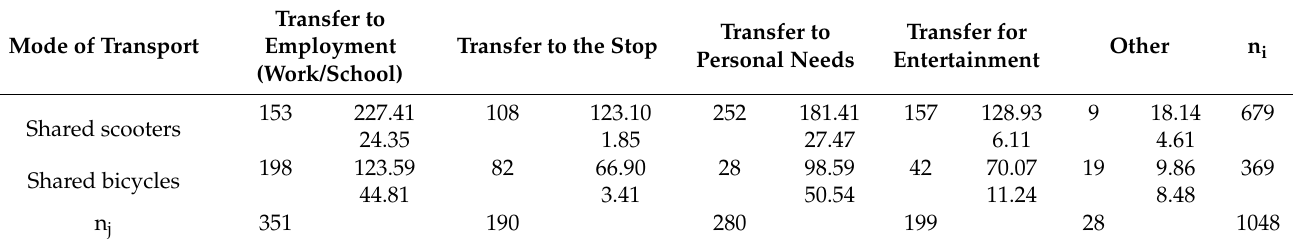
Table 3. Dependence of the reason for the journey on the mode of